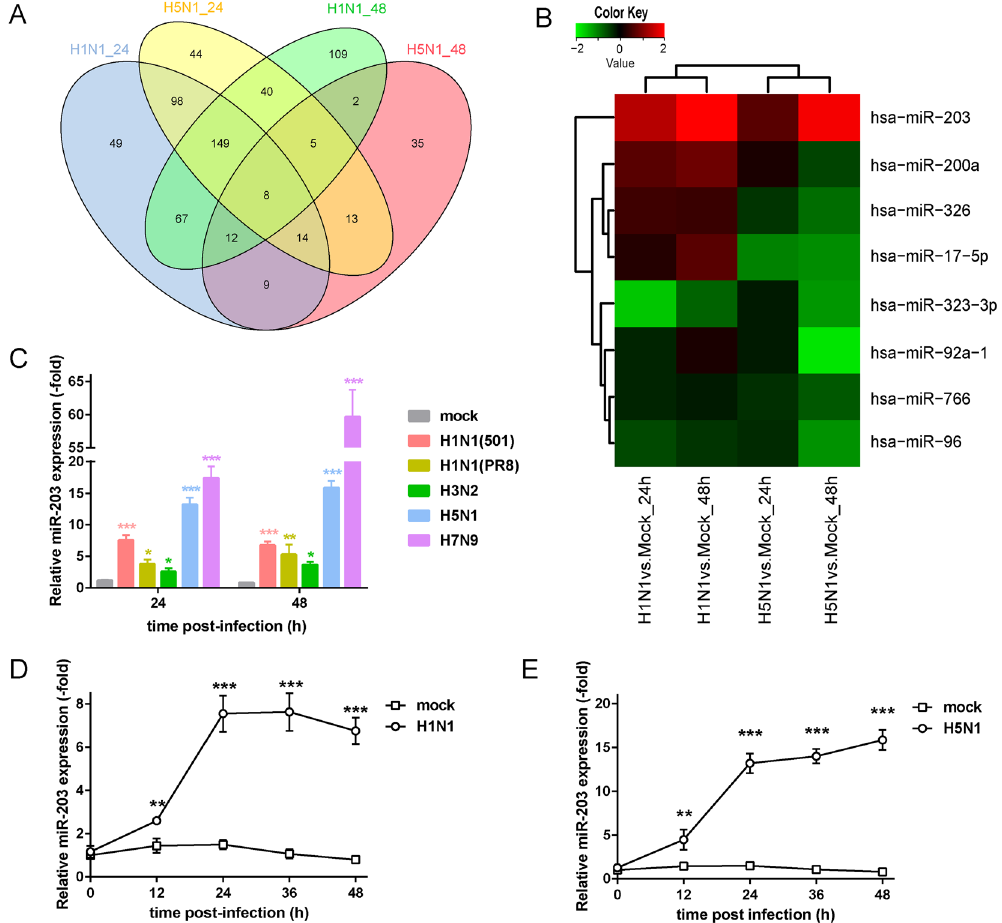
Figure 1. Influenza A virus (IAV) infection of A549 cells up-regulates expression of miR-203. ( A ) Venn diagram illustrates the numbers of miRNAs identified in each group and the number of common miRNAs within the four groups. ( B ) Heatmap of miRNA expression in A549 cells infected with H1N1 (501) and H5N1 viruses for 24 or 48 h. Each value for the virus/mock average signal ratio was expressed as log10 when drawing the Heatmap. Red denotes up-regulation, while green denotes down-regulation. ( C ) A549 cells were mock- infected or infected with H1N1 (501), H1N1 (PR8), H3N2, H5N1, or H7N9 for 24 or 48 h, and abundance of miR-203 was assessed by quantitative real-time PCR (qPCR). ( D and E ) A549 cells were mock-infected or infected with H1N1 (501) ( D ) or H5N1 viruses ( E ). Cells were harvested at different times (12, 24, 36, and 48 h), and dynamic changes in miR-203 expression were assessed by qPCR. Data are expressed as the mean ± SD of three independent experiments. * p < 0.05; ** p < 0.01; and *** p < 0.001 (Student’s t